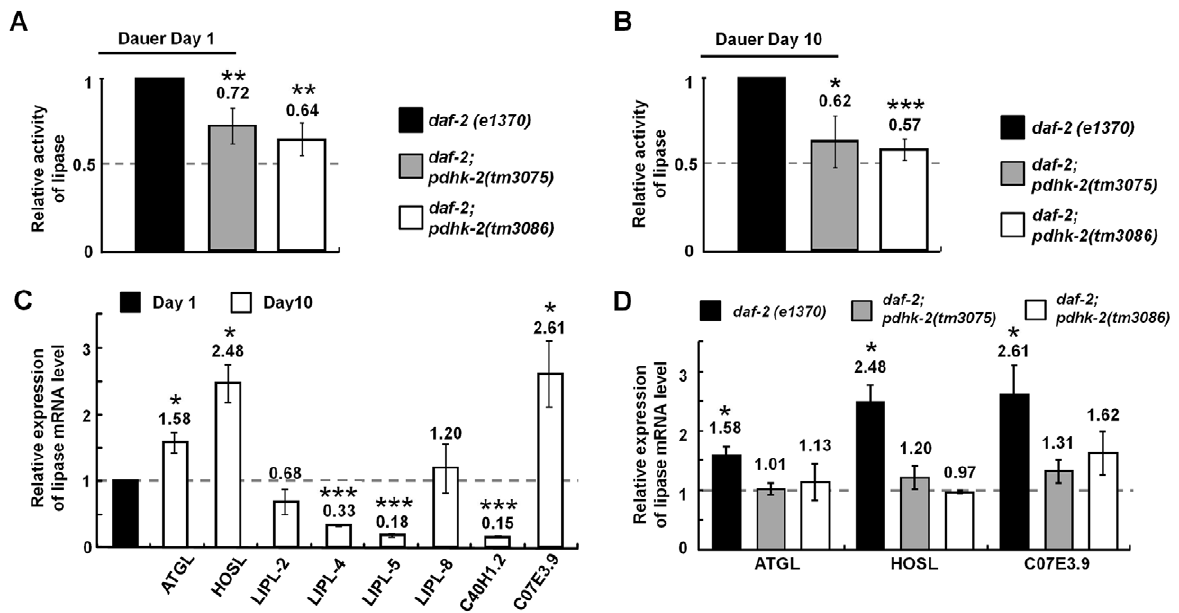
Figure 4. Expression pattern of lipases and their relative enzymatic activities in daf-2(e1370) controls and daf-2(e1370) ; pdhk-2 (tm3075)anddaf-2(e1370);(tm3086) double mutants. ( A ) Lipase activity of daf-2(e1370);pdhk-2 double mutants at dauer day 1, normalized to daf- 2(e1370) dauer worms. ( B ) Lipase activity of daf-2(e1370);pdhk-2 double mutants at dauer day 10, normalized to daf-2(e1370) dauer worms. The values represent means [ 6 SDs] from three independent experiments. ( C ) mRNA expression of lipases as determined by real-time qPCR in daf-2 (e1370) day 10 dauers. Data were normalized to daf-2(e1370) day 1 dauer worms. ( D ) Changes in lipase expression in daf-2(e1370);pdhk-2 double mutants compared to daf-2(e1370) in day 10 dauers. Data were normalized to day 1 dauer worms. Dauer worms were obtained from synchronized L1 stage worms after 60 hours at 25 u C. The values represent means [ 6 SDs] from two independent experiments. * p , 0.05, ** p , 0.01 and *** p , 0.001 compared with the control.